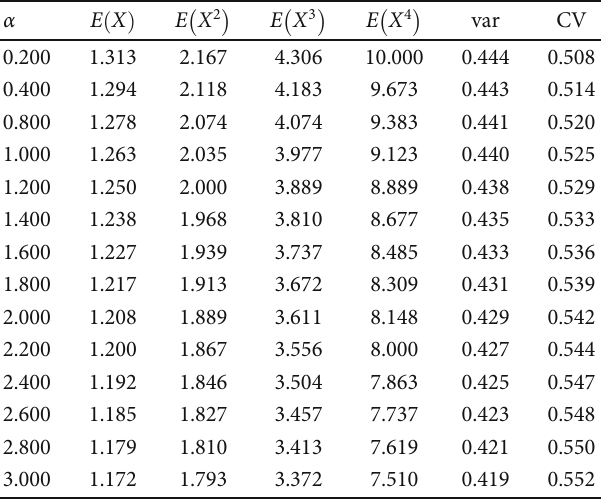
Table 5: Summary statistics of some moments of DWQL distribution at α = 5 : 0 and various values of θ .